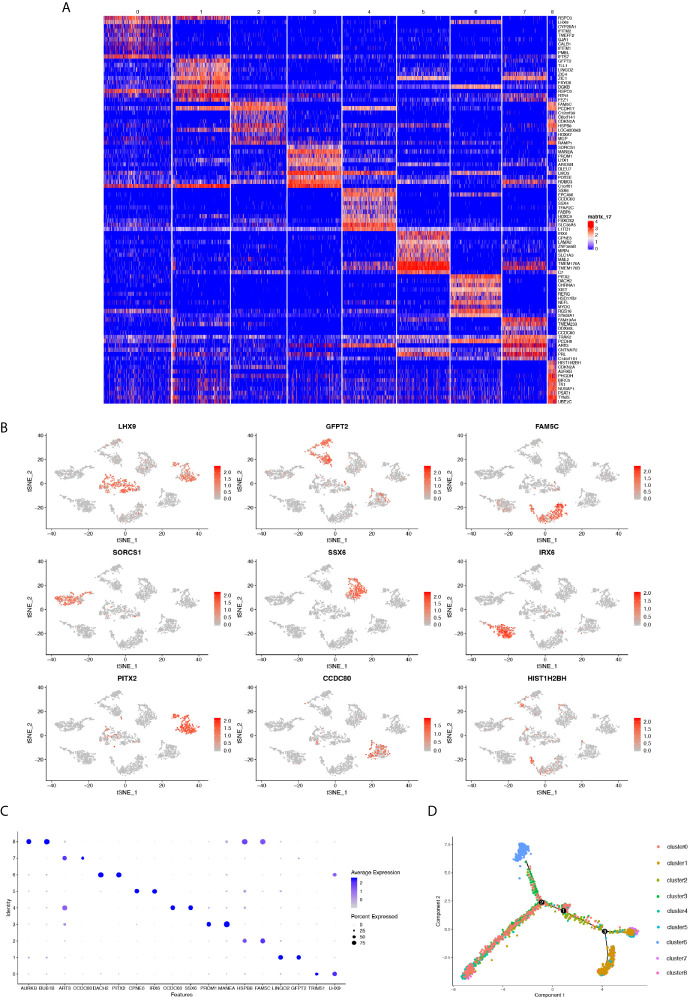

(A) Heatmap showing the genes differentially expressed in each cluster. (B) t-SNE plots of marker gene expression levels in each cluster. (C) Bubble plot depicting the expression level of selected genes in each cluster. Color depth represents average expression level and bubble size the percentage of expression. (D) Cell trajectory analysis showing five main cell branches.